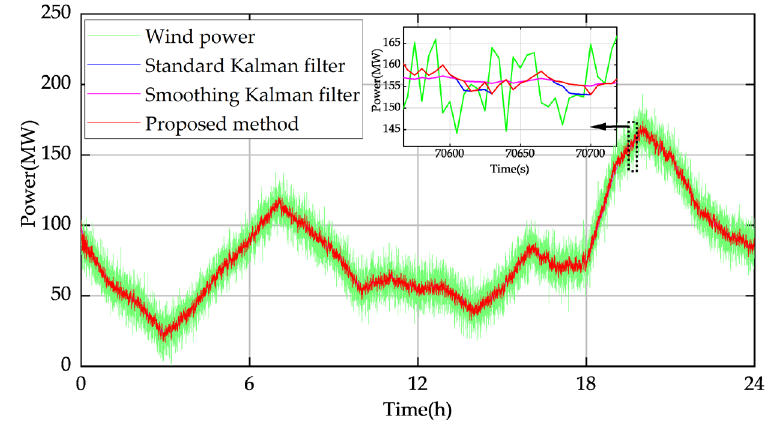
Figure 10. The wind power before and after smoothing.